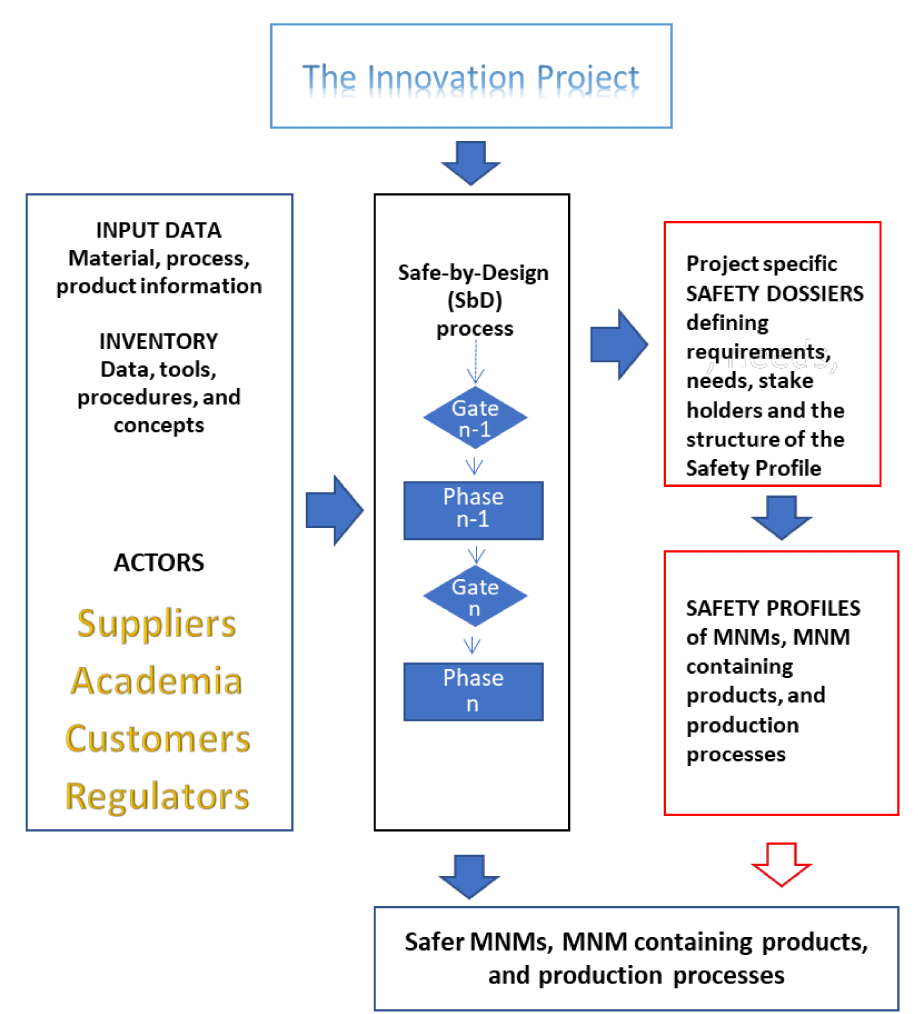
Figure 2. Overview of the SbD implementation process including data inputs, procedures, and the output as Safety Dossier and Safety Profile of the material/ product under